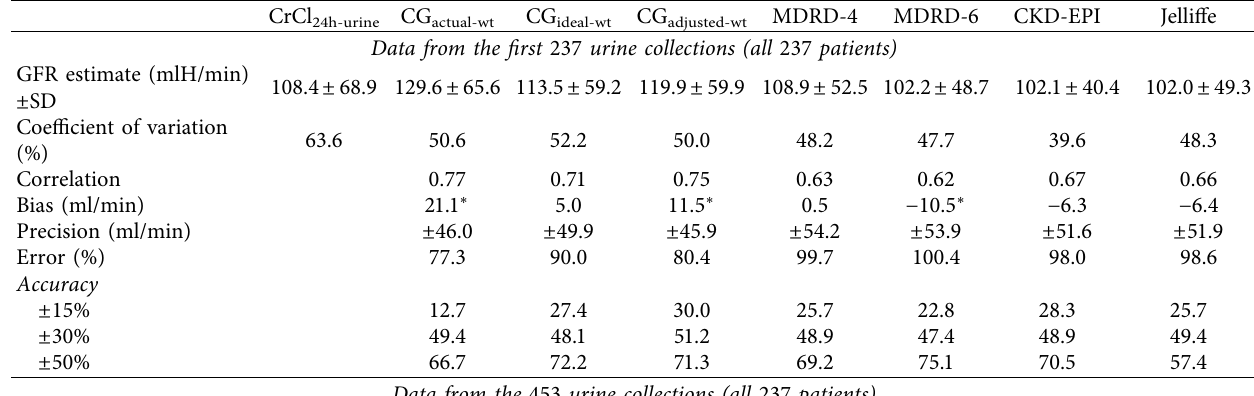
Table 3: Predictive performance of equations estimating glomerular filtration rate compared with creatinine clearance (CrCl measured by 24-hour urine